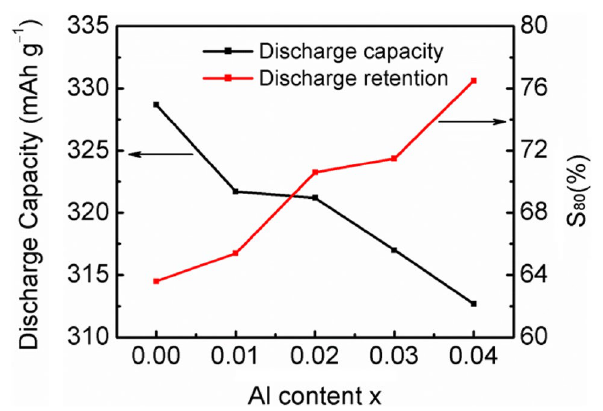
Fig. 8 Relationship between the capacity retention rate (S content ( x ) of the Re 2 Mg(Ni 0.7 − x Co 0.2 Mn 0.1 Al x ) 9 ( x = 0 ‒ 0.04) alloys